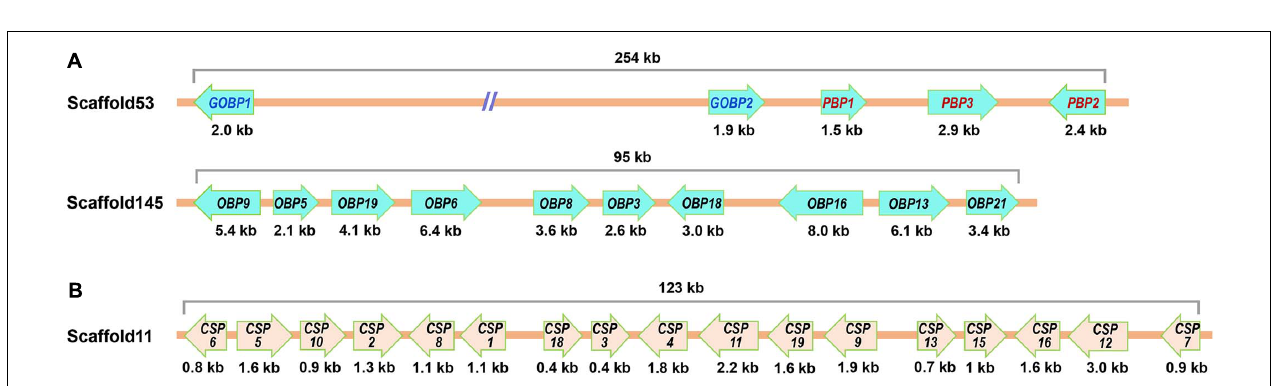
FIGURE 9 | Genomic location of OBP s (A) and CSP s (B) in G. mellonella .